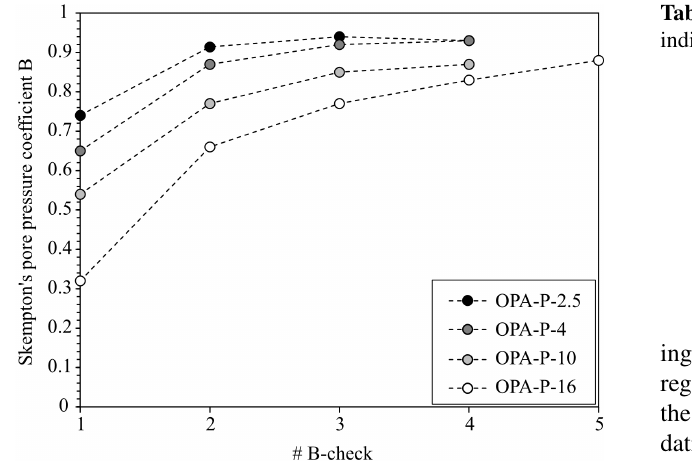
Figure 3. Skempton B values demonstrating the saturation of the samples. Experiments are numbered according to the sequence of performance with increasing effective consolidation stresses used, i.e. 2.5, 4, 10, and 16MPa.